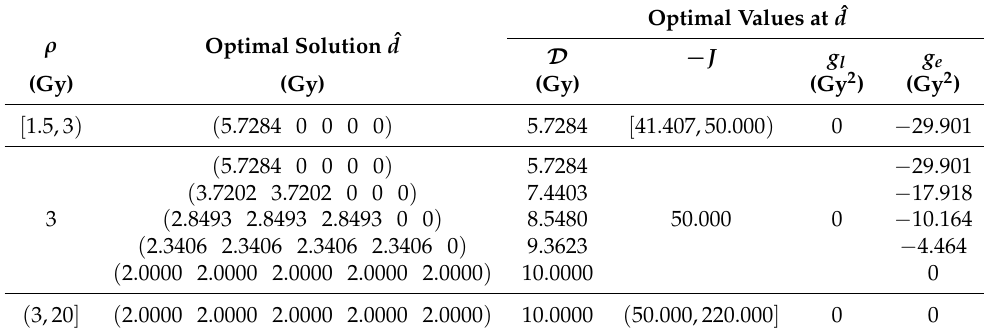
Table 4. Numerical solutions to Problem 1 in the absence of incomplete repair for ρ ∈ [ 1.5,20 ] Gy. h l = 50.0 Gy 2 , h e = 120.0 Gy 2 computed by Equation (17) with ¯ d = 2 Gy. ˆ d : optimal solution; D : optimal total dose.